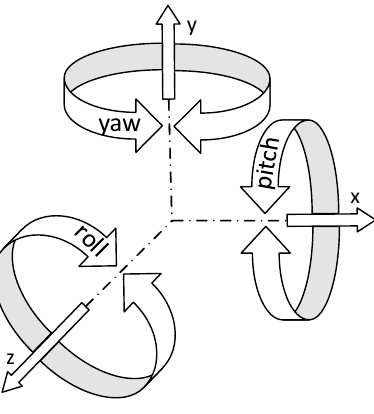
Figure 7. Euler angles.